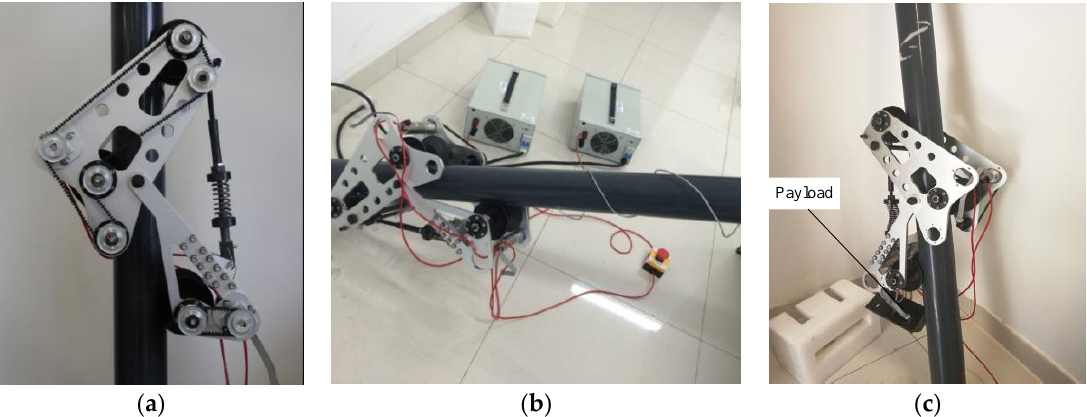
Figure 15. Climbing test of the robot. ( a ) Climbing on the smooth surface; ( b ) Climbing on the surface with obstacles; ( c ) Load test.